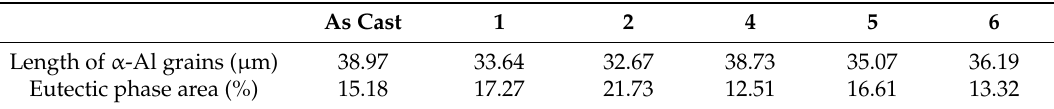
Table 5. Quantification results based on microstructure image analysis: 1—after vibration by 100 Hz; 2—after vibration by 150 Hz; 4—after modification by ultrafine powder modifier; 5—after modification